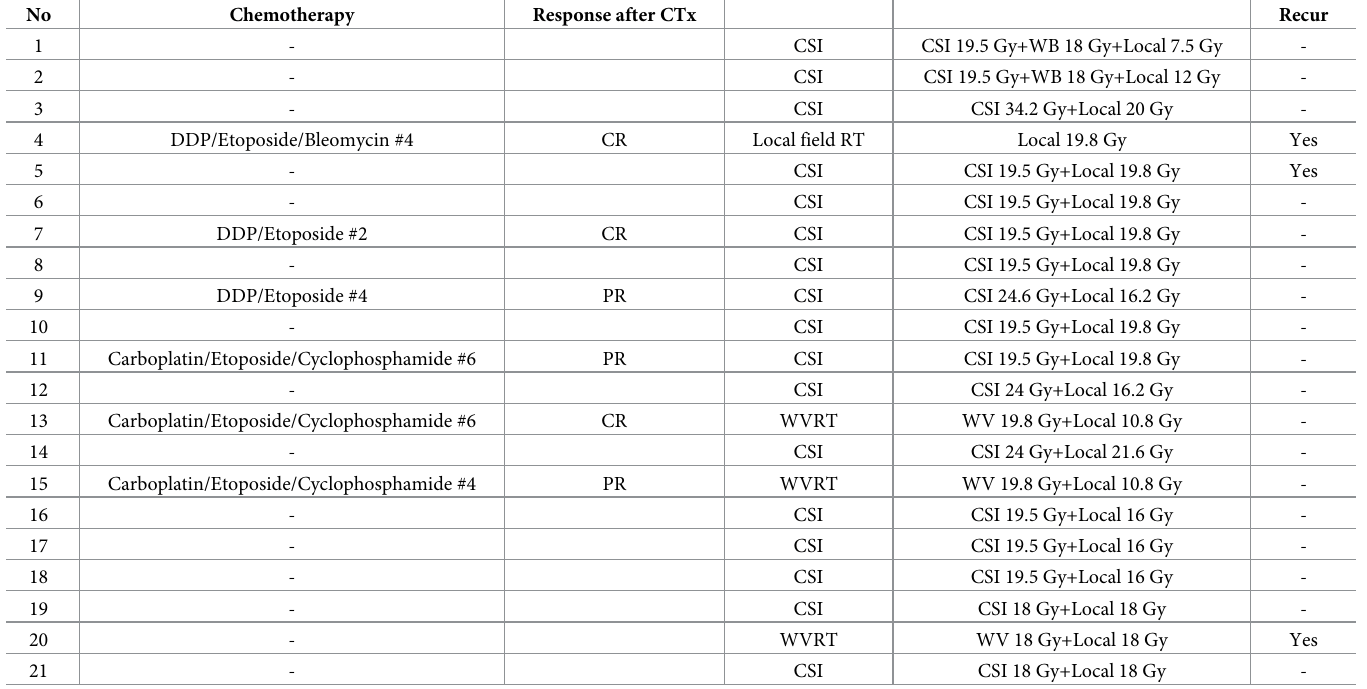
Table 2. Treatment characteristics. Treatment characteristics including chemotherapy regimen and radiotherapy